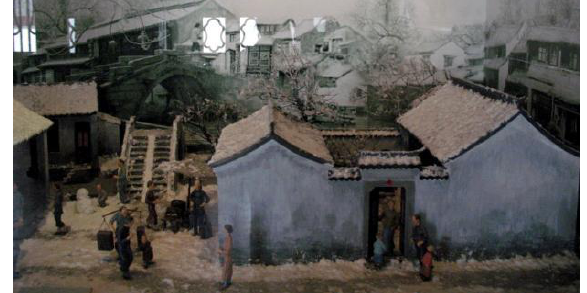
Figure 3. Model of a small riverside courtyard house in Suzhou Folk Custom Exhibition Center. Photo: Donia Zhang